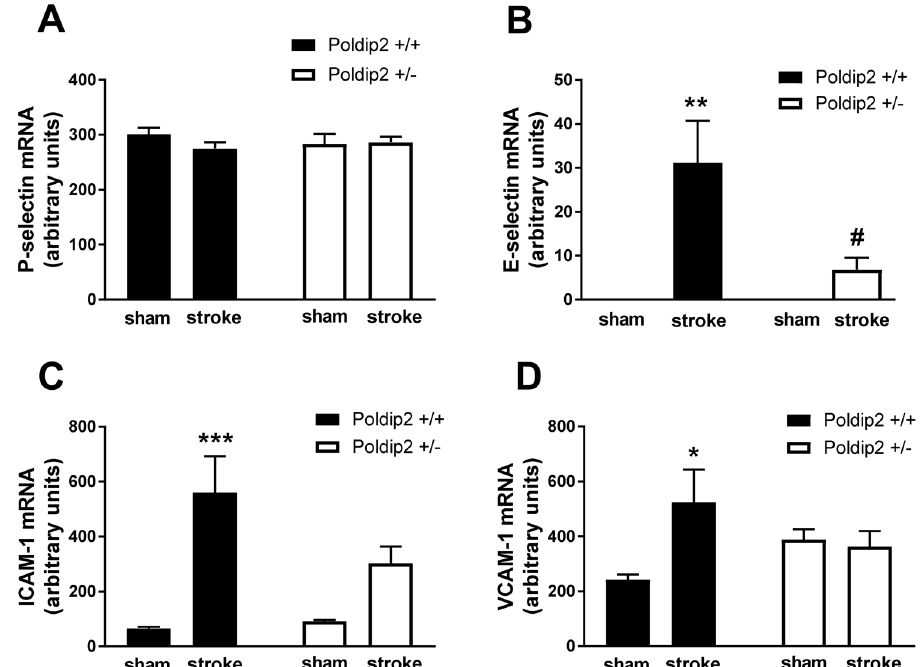
Figure 2. Poldip2 depletion reduces the induction of leukocyte adhesion molecules in vivo. P-selectin ( A ), E-selectin ( B ), ICAM-1 ( C ) and VCAM-1 ( D ) and mRNAs were measured by RT-PCR in the brain tissue 24 h after sham surgery or hypoxia-induced permanent stroke in Poldip2 +/+ and +/− mice. Bar graphs represent means ± SEM from 5 to 9 mice per group normalized to GAPDH. Two-way ANOVA *P < 0.05, **P < 0.01, ***P < 0.001 vs. Poldip2 +/+ sham mice and # P < 0.05 vs. Poldip2 +/+ ischemic